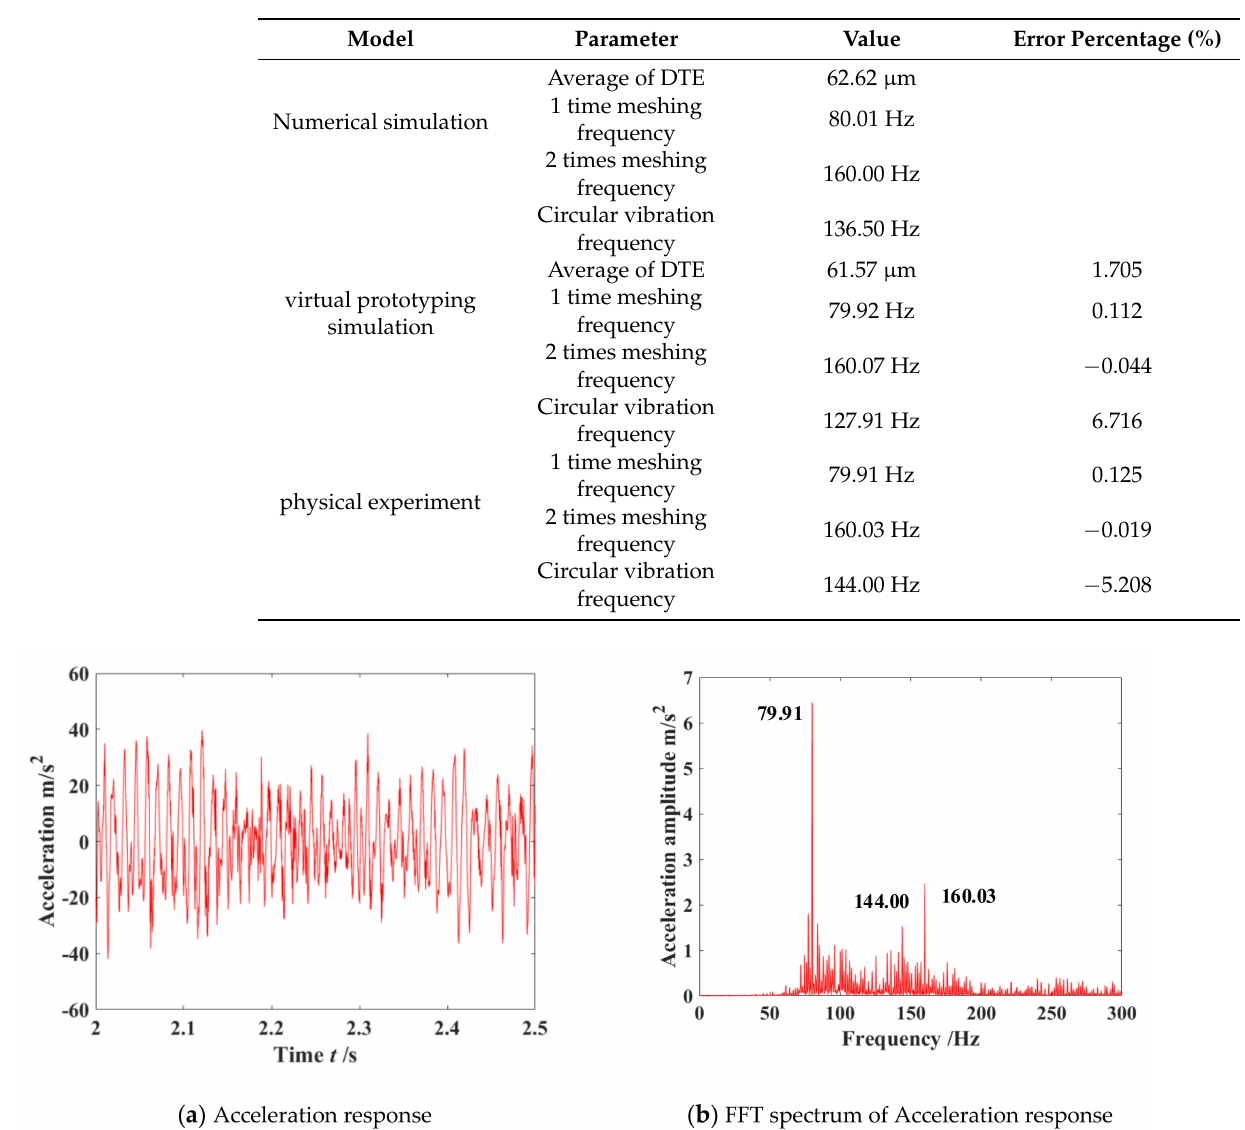
Table 2. Comparison results of numerical simulation, virtual prototyping simulation and physical experiment.